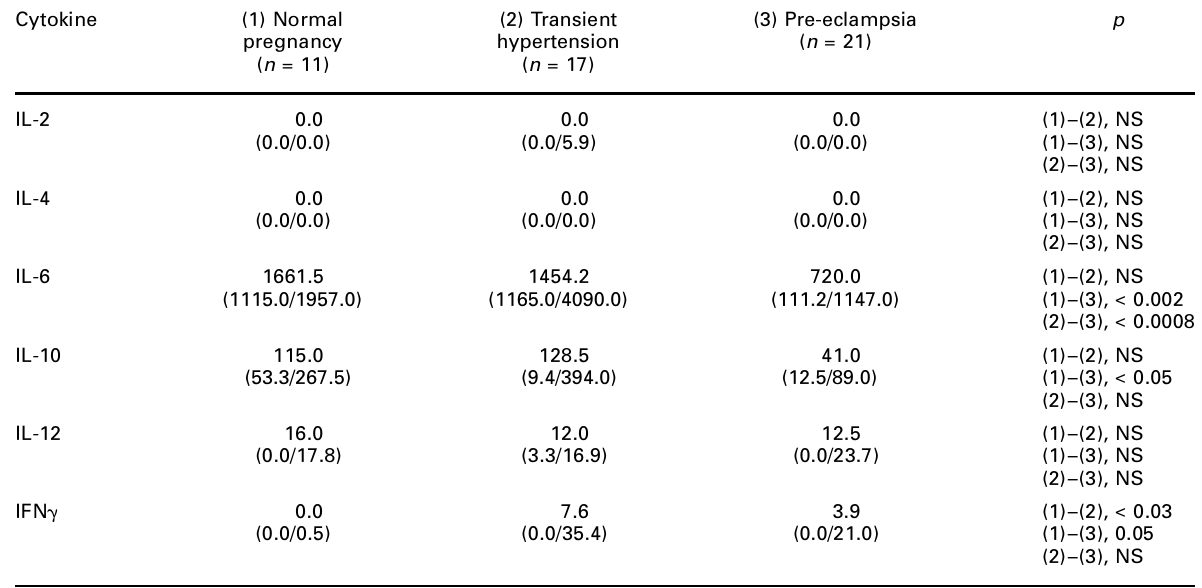
Table 3. Spontaneous cytokine secretion (pg/ml) from cultured decidual lymphocytes of normal pregnant women, and pregnant patients with transient hypertension and pre-eclampsia